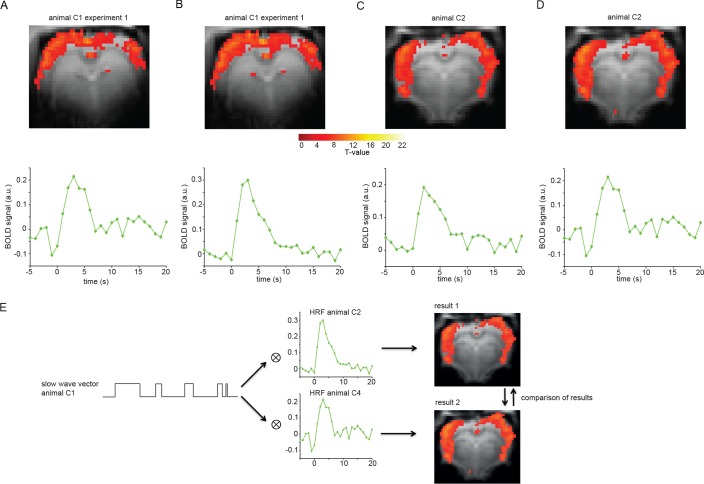
Cross-validation procedure to test for impact of respective dataset used for HRF extraction.(A) Animal C1 experiment 1 analyzed with HRF extracted from animal C4; cluster size = 810, T-value (max.)=10.86. (B) Same animal as in (A) analyzed with HRF extracted from animal C2; cluster size = 641, T-value (max.)=11.36. (C) Animal 2 analyzed with HRF extracted from animal C1 (average of both experiments); cluster size = 1492, T-value (max.)=13.16. (D) Same animal as in (C) analyzed with HRF extracted from animal C4; cluster size = 1912, T-value (max.)=13.95. (E) Flow chart depicting cross-validation procedure.